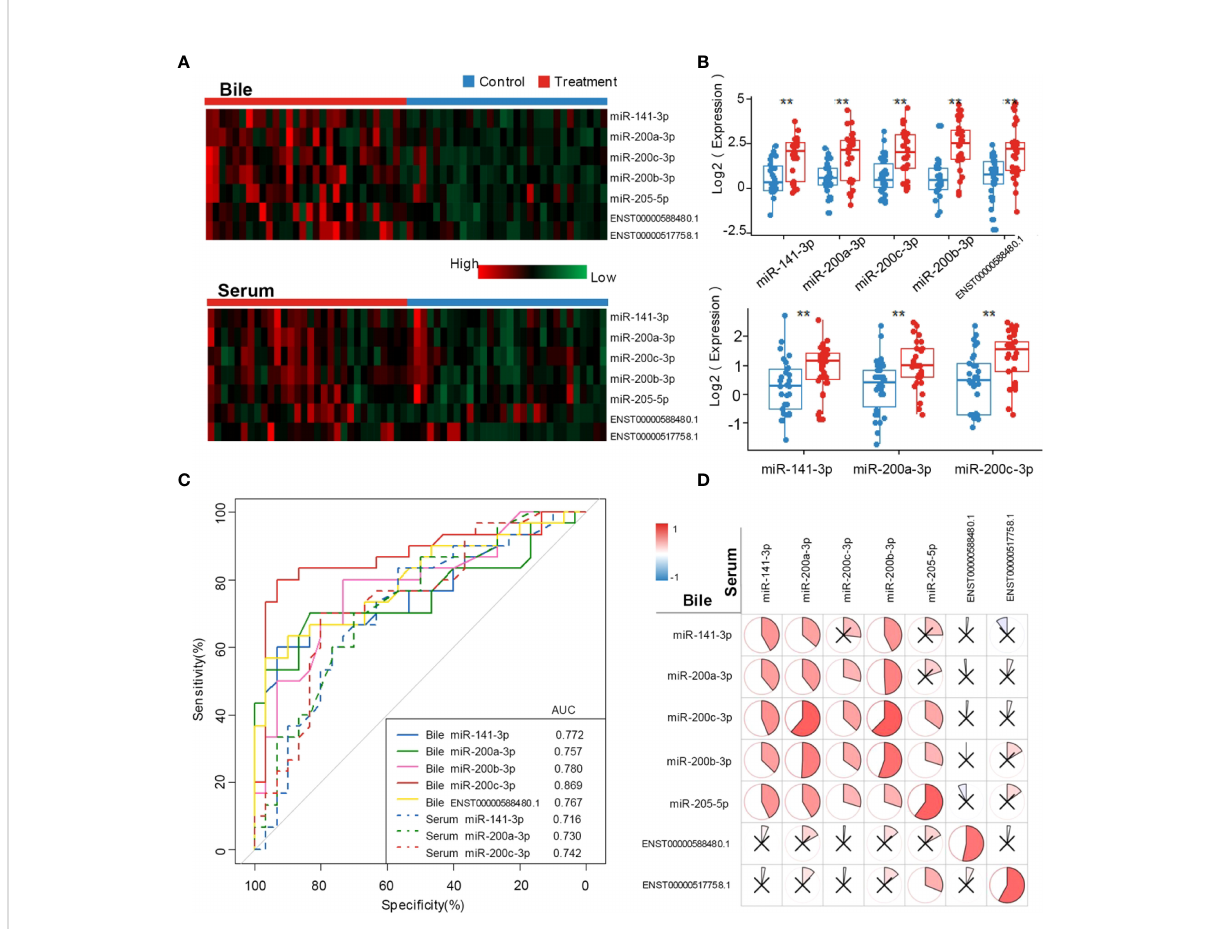
FIGURE 1 Exosomal ncRNAs in human bile and serum. (A) Heatmap showing the expression of exosomal ncRNAs in human bile and serum; (B) Signi fi cantly differential expressed exosomal ncRNAs between CCA group and control group; (C) The AUCs of exosomal ncRNAs in the diagnosis of CCA; (D) The correlation between serum and bile exosomal ncRNAs. **: vs. control